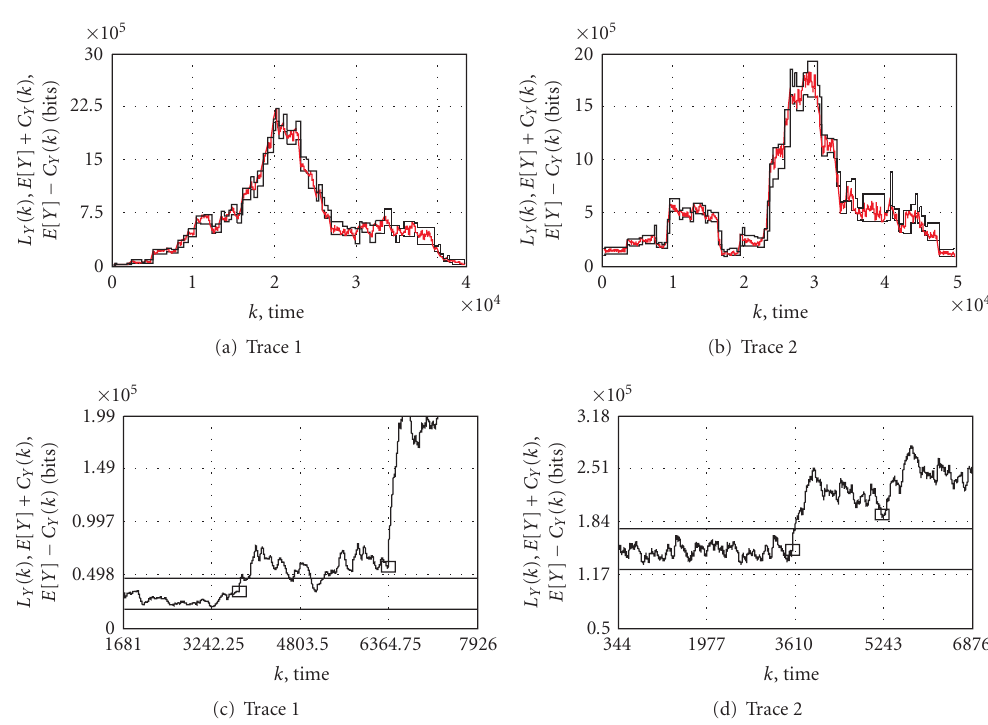
Figure 11: EWMA statistics: varying number of sources ( γ = 0 . 01).